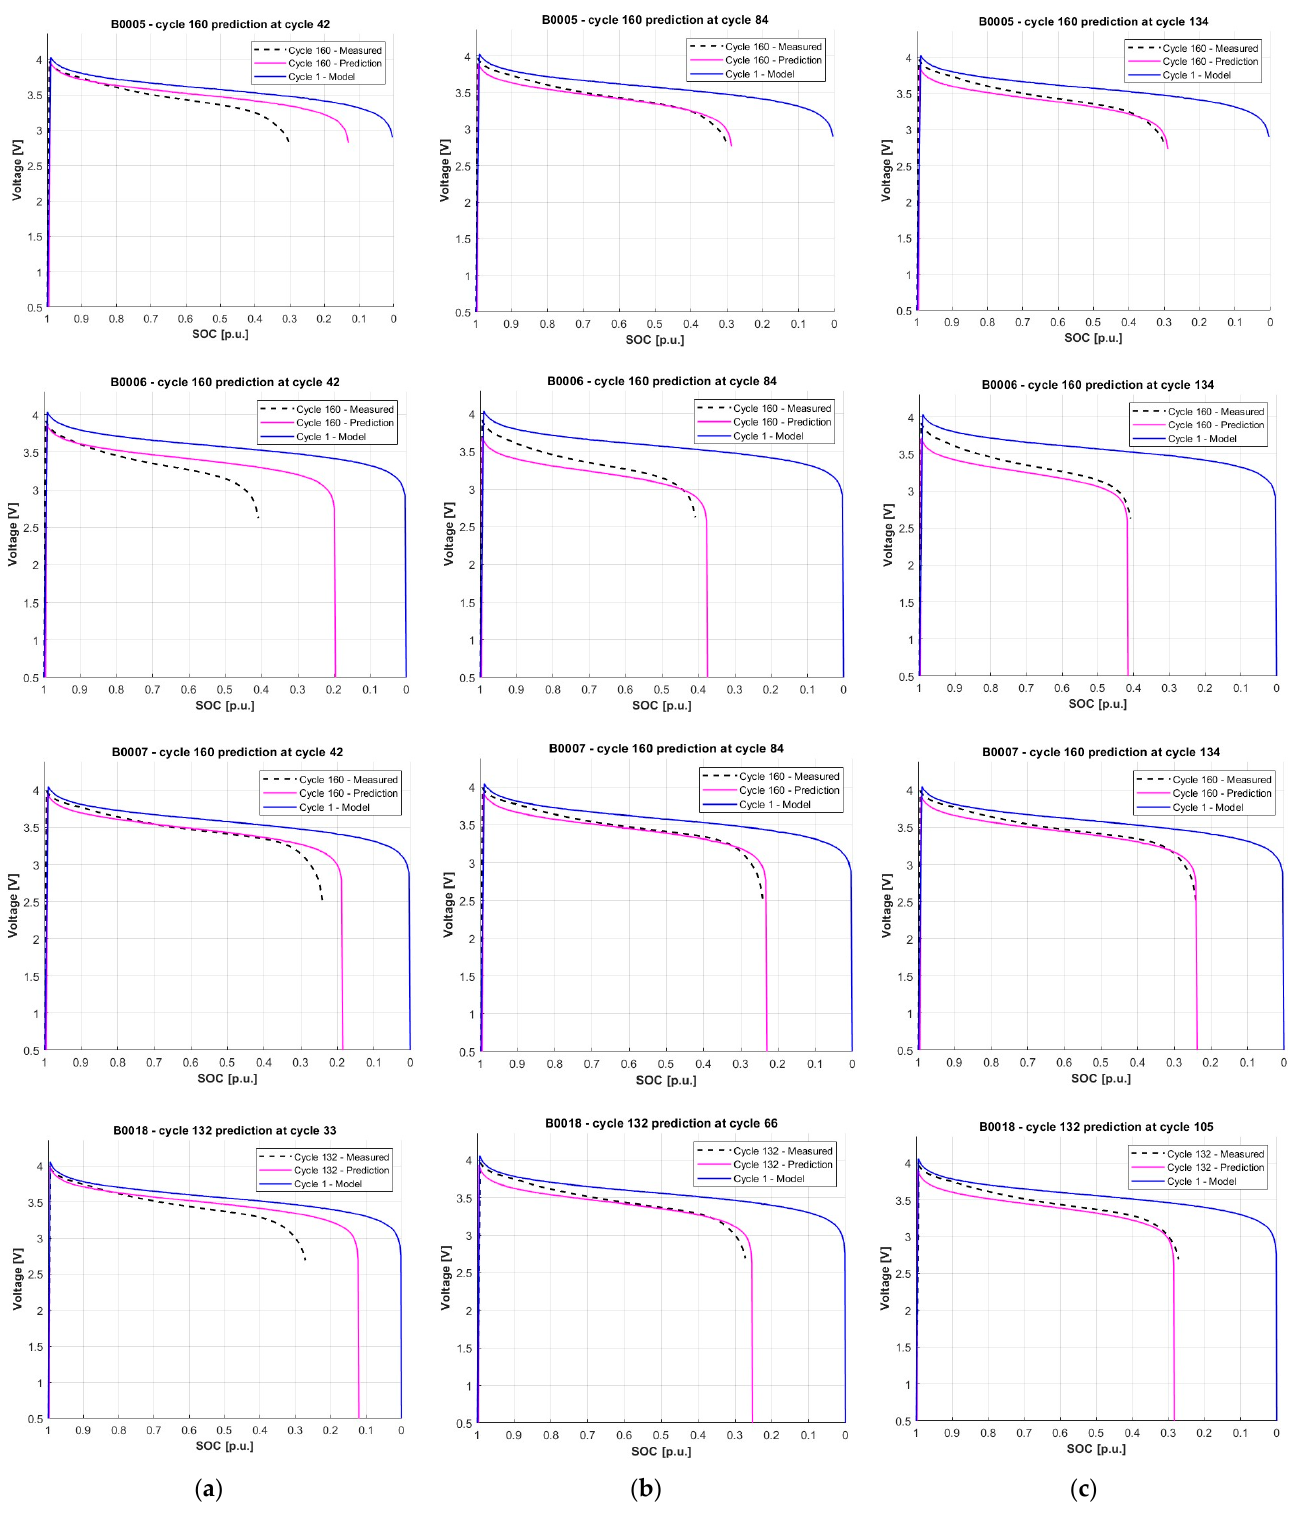
Figure 8. Prediction of future discharge cycles at different stages of cell aging. ( a ) Prediction of future cycle using 25% useful life data. ( b ) Prediction of future cycle using 50% useful life data. ( c ) Prediction of future cycle using 80% useful life